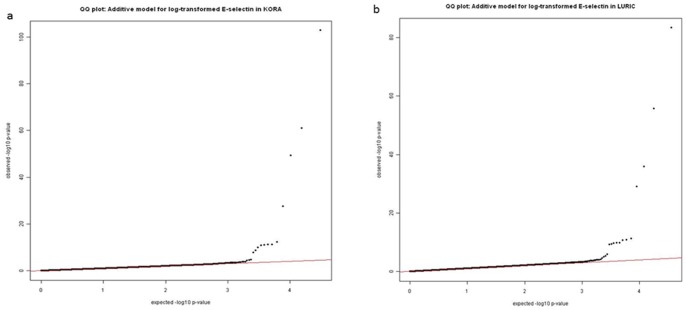
Q-Q plots for KORA (a) and LURIC (b).